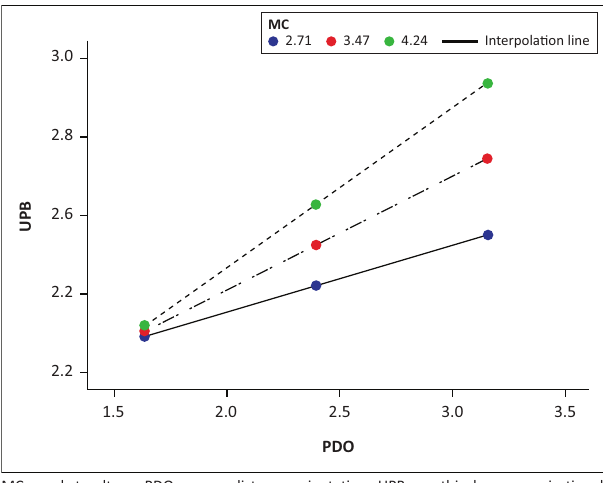
FIGURE 4: The higher the market culture, the stronger the influence of power distance orientation on unethical pro-organizational